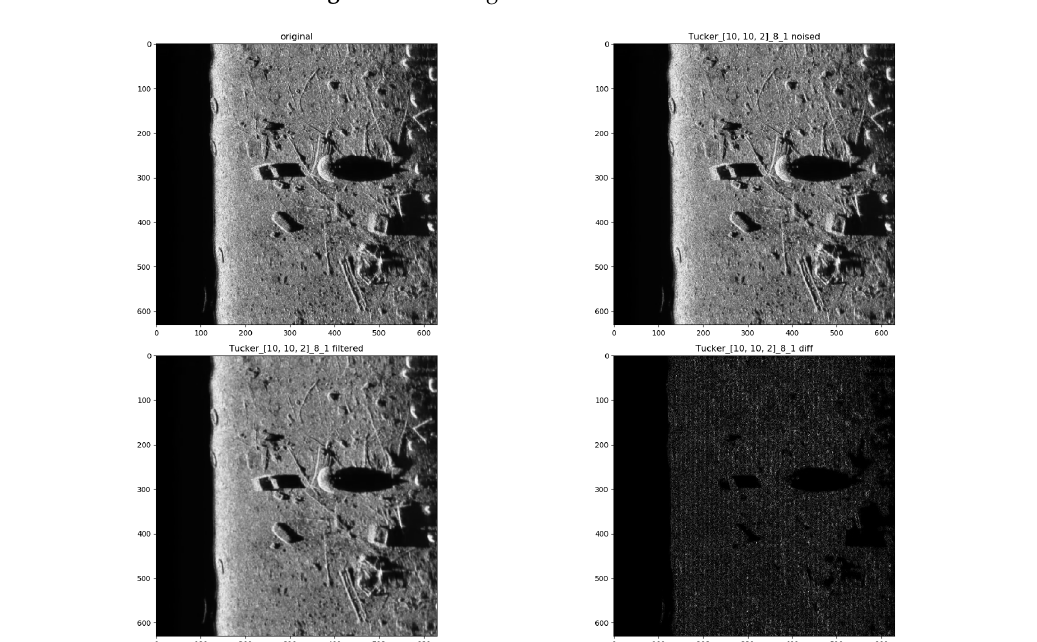
Figure 14. Filtering results for Median filter.